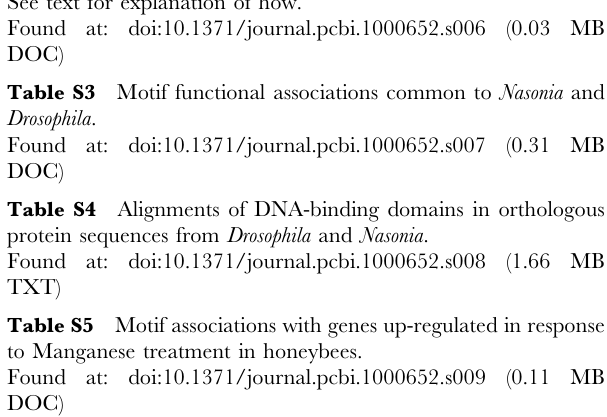
Table S6 Enrichment p-values for the oxidative phosphorylation gene set in Nasonia